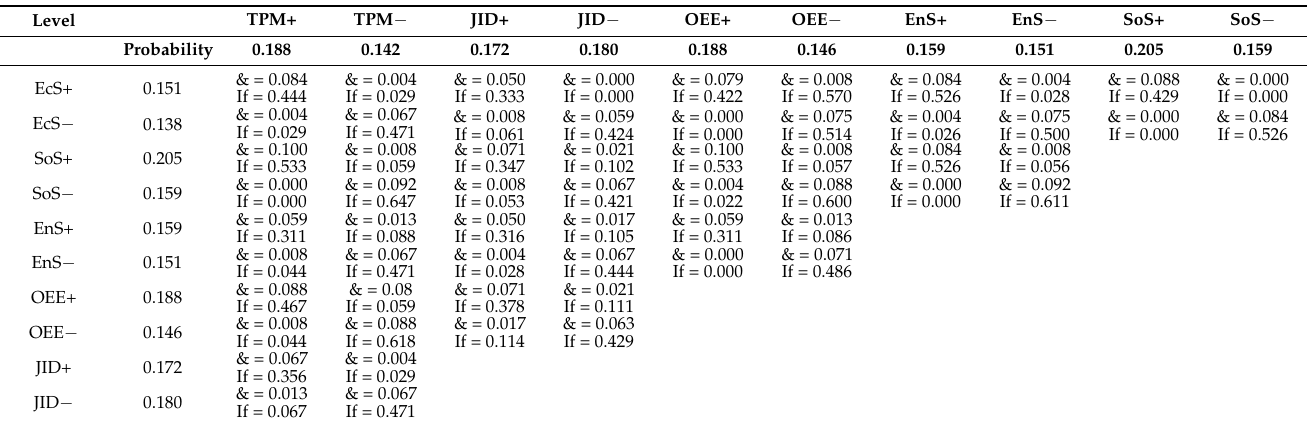
Table 6. Probability of low and high LM